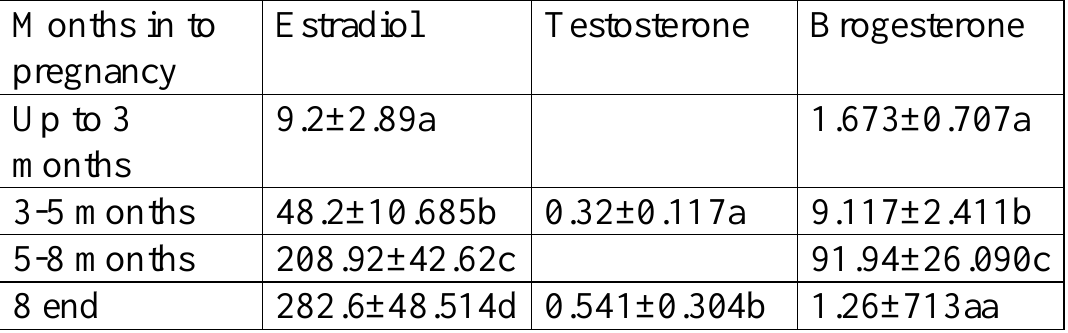
Table (1): Serum progesterone ng/ml , Testosterone ng/ml and Estrogen pg/ml Concentration During Pregnancy in cow .